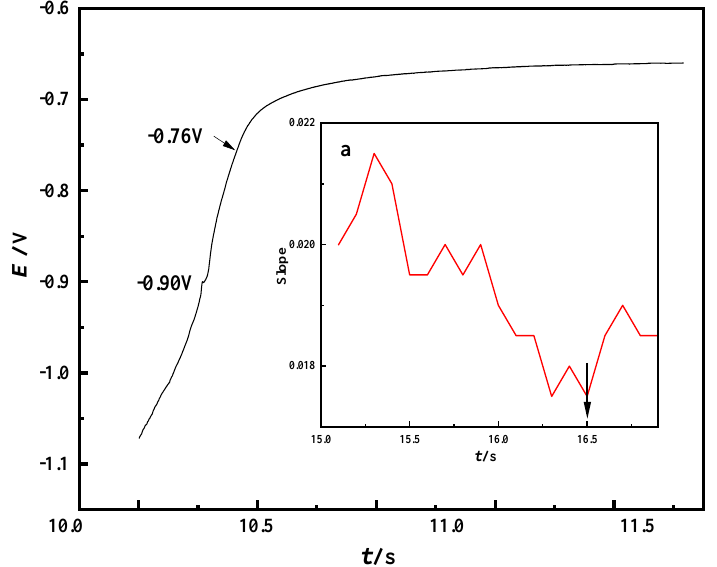
Figure 8. Open circuit chronopotential curve of Mo electrode in NaCl-CaCl 2 -LiNiO 2 molten salt system ( a ) Slope graph at different times ( T = 750 °C, reference electrode: Pt electrode).